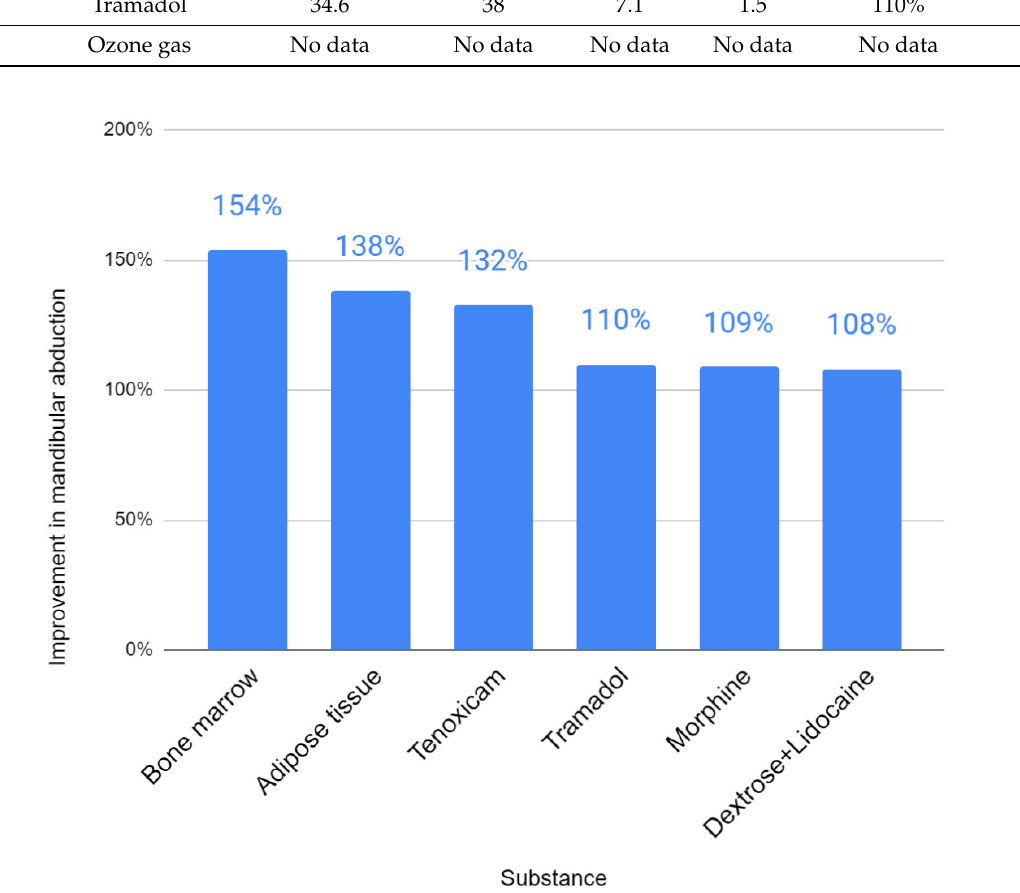
Figure 4. Improvement in mandibular abduction (the greater the value, the better the result). Among the substances other than those already assessed in the previously published meta-analyzes, only the administration of dextrose with lidocaine was documented in more than one report, which limited the possibility of the meta-analysis to this one substance [12,18,20,21,24,44,49,62]. The amplitude of mandibular abduction was reported only in two of the three reports, which precludes any statistical analysis. The three initial and three final pain values obtained from the study allowed for fitting a linear regression model of pain intensity of the formula − 3.2x + 7.7 with standard deviations of 0.5 and 2.0 for the initial and final TMJ pain intensity, respectively (Figure